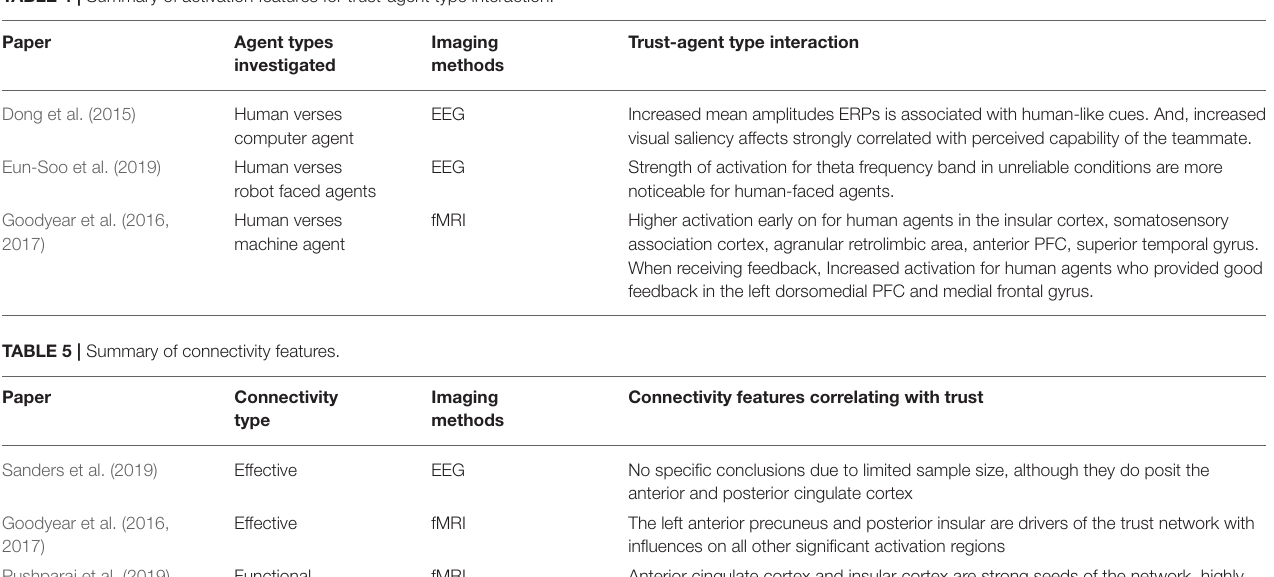
TABLE 4 | Summary of activation features for trust-agent type interaction.